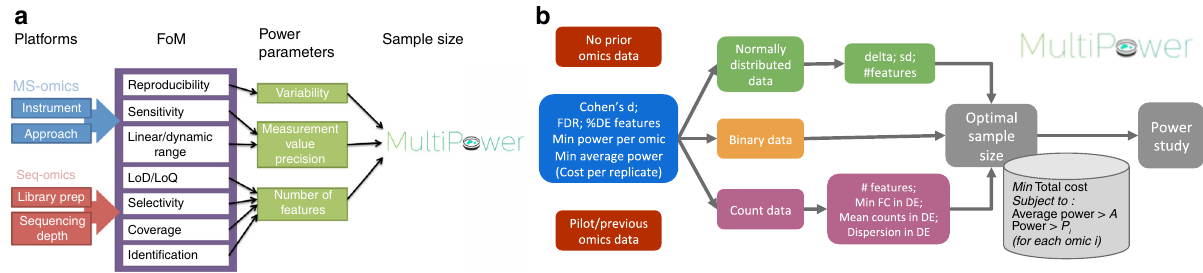
Fig. 3 The MultiPower approach. a Relationship between omic platforms (MS in blue and sequencing in red), FoM (purple), power parameters (green), and MultiPower. MS- and seq-based omics have different key properties that determine their FoM, which in turn affect differently to power parameters used as input by MultiPower to compute sample size in multi-omics experiments. b Overview of the MultiPower method. MultiPower works either with no prior data and with pilot data (red boxes). The blue box contains the parameters to be set by users. Green, orange, and purple boxes represent the data types accepted by MultiPower and the rest of power parameters estimated by MultiPower from prior data when available or given by the user. MultiPower solves an optimization problem to estimate the optimal sample size and to provide a power study of the experiment